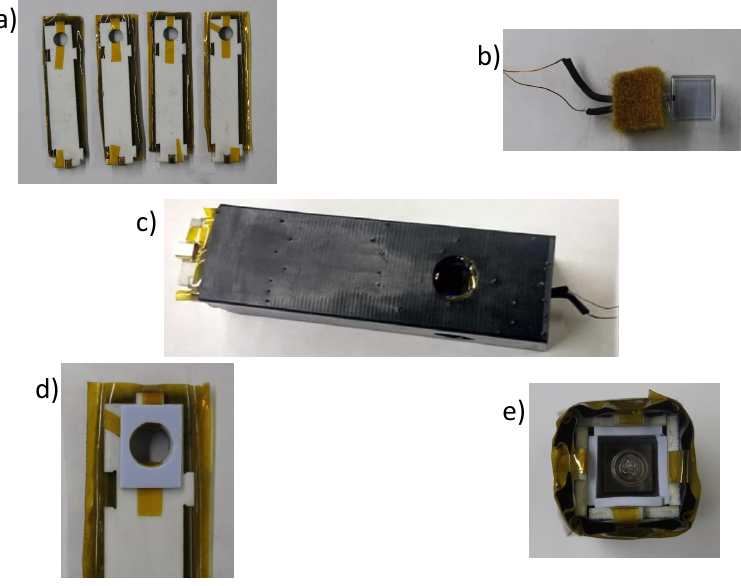
Figure 1. Vapor cell heater and cartridge mount photographs. ( a ) Four ceramic jig heater sides with aerogel pillows attached to outer faces. AC power enters via MMCX connectors at the bottom of each jig heater. ( b ) 1 cm 3 vapor cell with stem tucked into fiberglass insulation. A temperature sensor sits between the insulation and outer cell wall. ( c ) Cartridge with cell installed. ( d ) Gap fill shim on one jig heater face. ( e ) View looking into the jig heater with the cell installed. Note the four pieces of gap fill between each outer cell wall and the jig heater inner